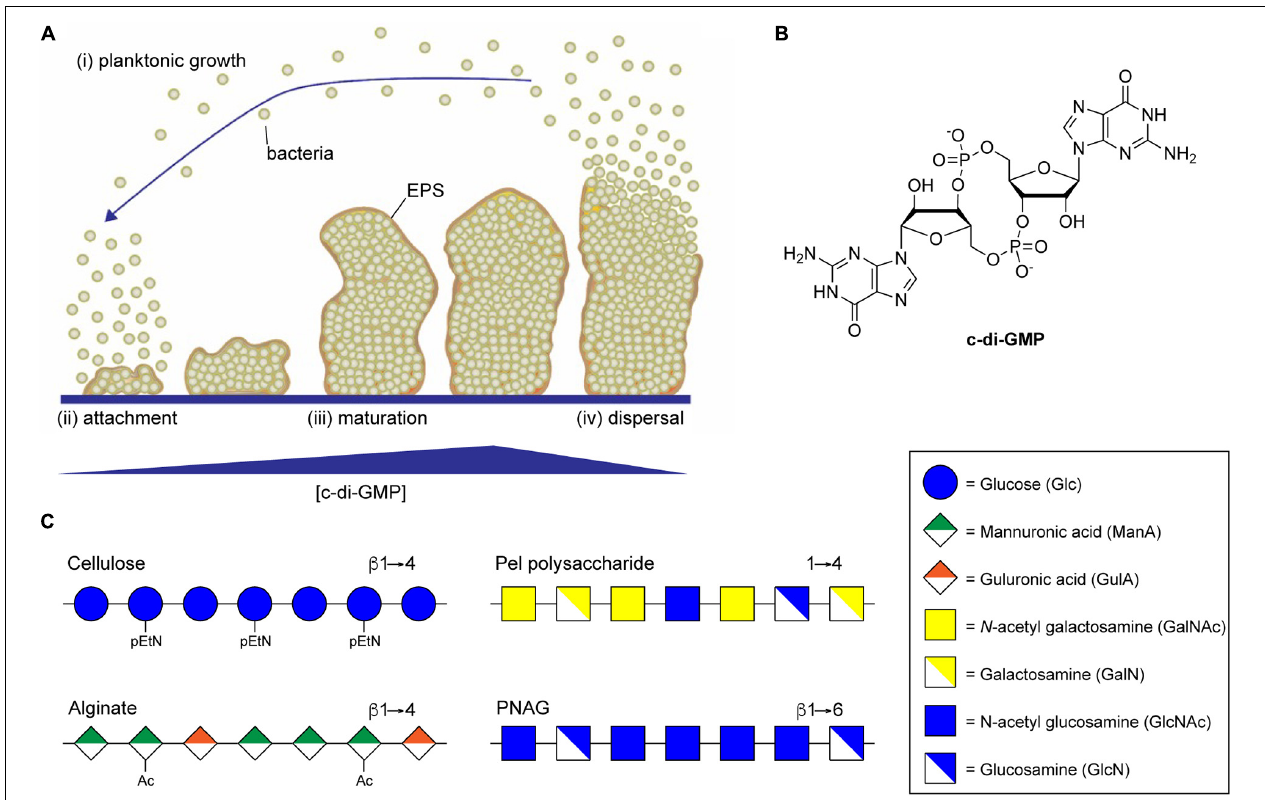
FIGURE 1 | Biofilm formation is regulated by c-di-GMP. (A) Biofilm development begins when planktonic bacteria ( i ) attach to a surface through the action of specific adhesins or non-specific surface hydrophobicity ( ii ). Increasing intracellular concentrations of c-di-GMP then result in secretion of biofilm EPS components, including exopolysaccharide, leading to the maturation of complex three-dimensional biofilm microstructures ( iii ). Eventually, decreasing concentrations of c-di-GMP lead to the production of dispersal agents, surfactants and cell motility factors resulting in dispersal of planktonic bacterial from the biofilm ( iv ). (B) Structure of the di-nucleotide second messenger, c-di-GMP. (C) Representative structures of the biofilm exopolysaccharides cellulose, alginate, Pel, and